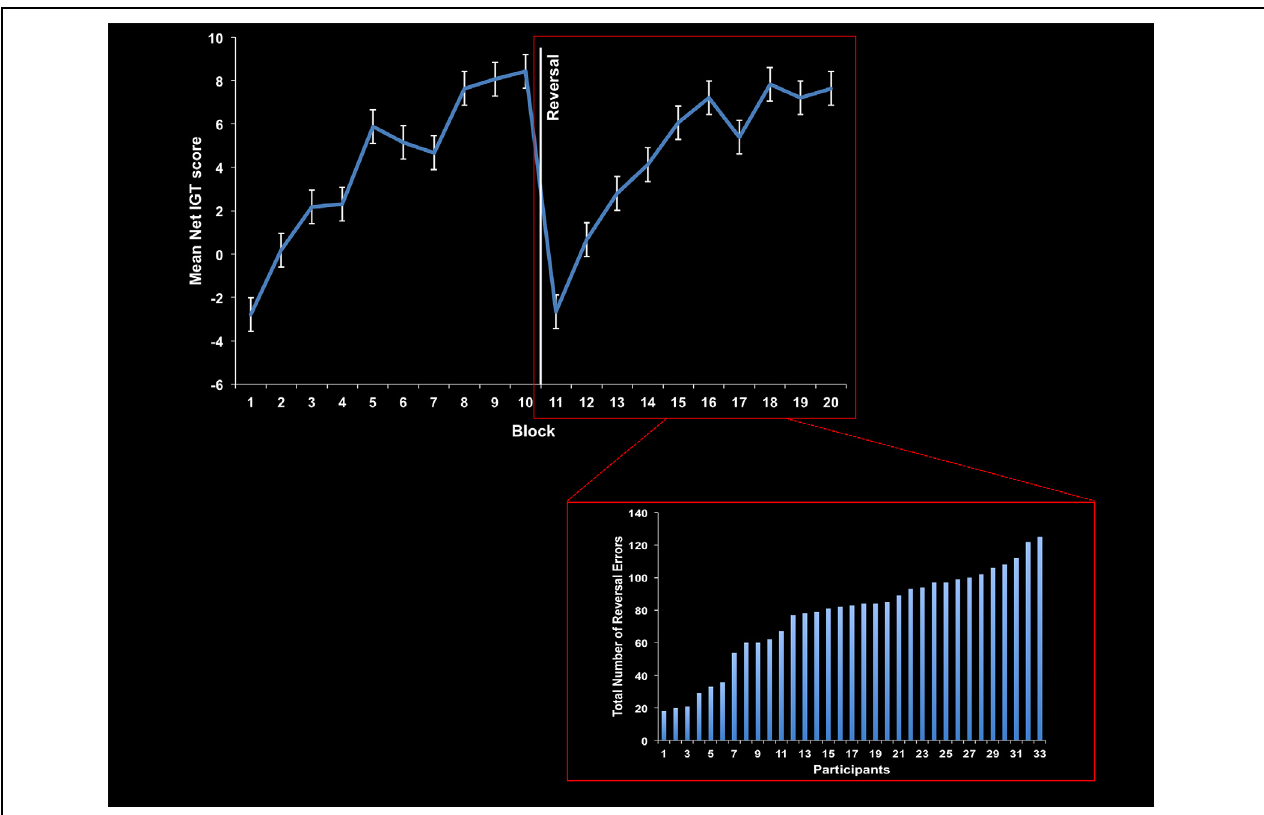
FIGURE 1 | Behavioral performance on the Iowa Gambling Task (IGT). Group performance is plotted across test blocks (top) . IGT net score reflects the sum of disadvantageous deck choices subtracted from the sum of advan-